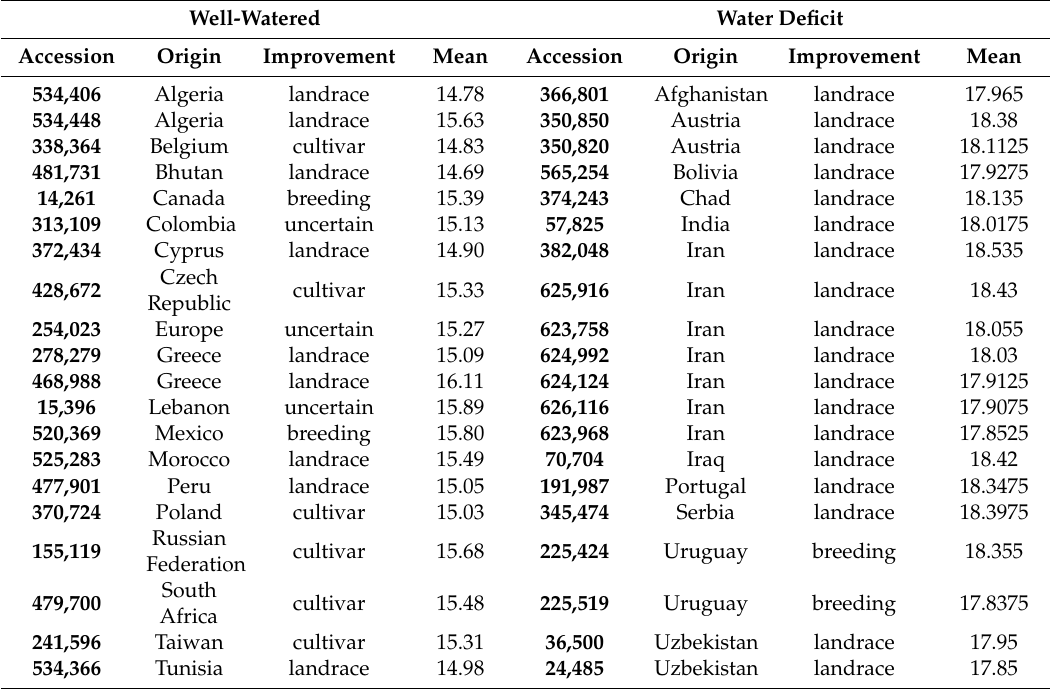
Figure 2. The overall performance of the 2111 wheat accessions across the two growing seasons under water deficit and well ‐ watered growth conditions. Table 2. Lsmean values of the grain protein content (GPC) of 20 accessions with the highest values across 2015/2016 and 2016/2017 growing seasons obtained from well ‐ watered (control) and water ‐ deficit conditions.